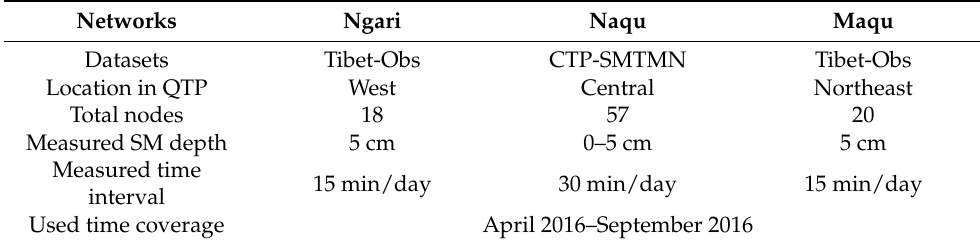
Table 1. Summary of the basic information of the three in situ networks. Networks